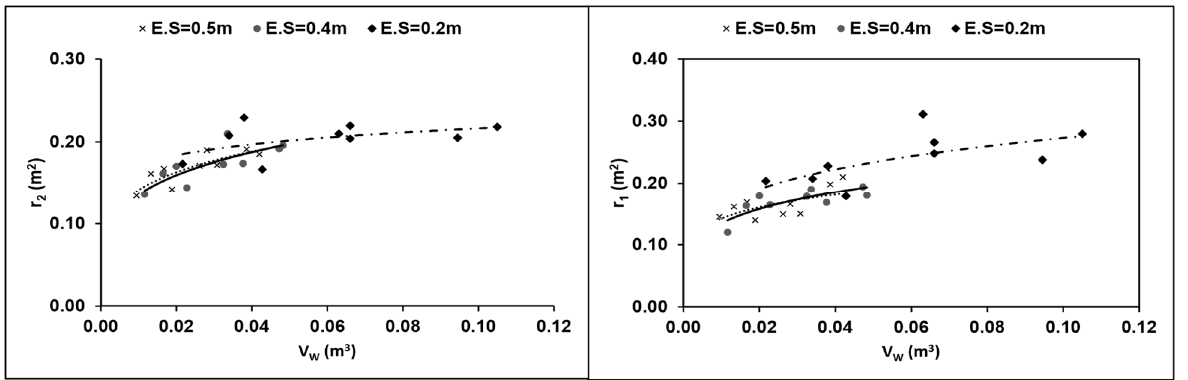
Figure 8. Relationship between the radiuses of the first and last cross-sections ( r 1 &r 2 ) and volume of water discharged ( Vw ) of the drip laterals with emitter spacing of 20, 40, and 50 cm.